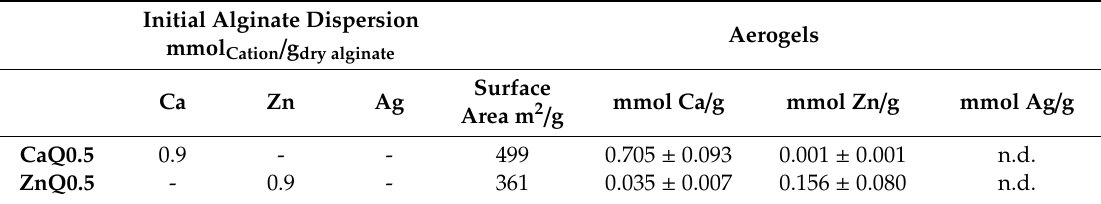
Table 1. Characteristics of the aerogel